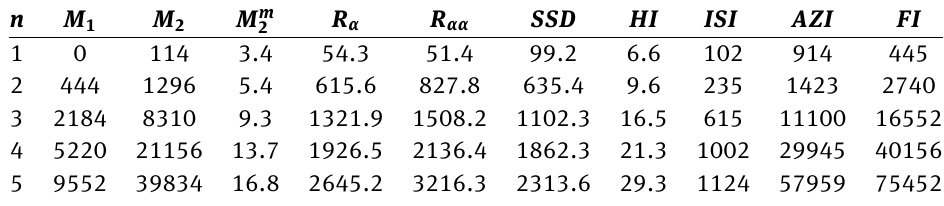
Table 5: Comparison of all indices for HDN 2( n ) .